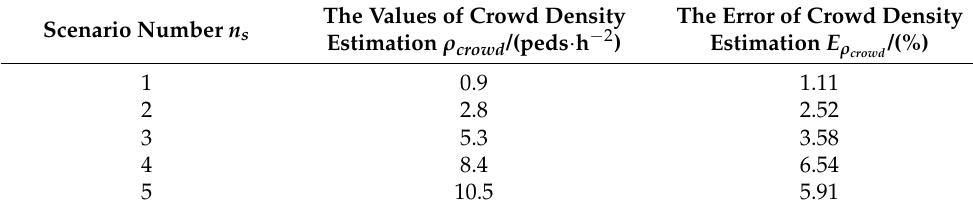
Table 3. Analysis of the accuracy of crowd density estimation. Table 2. Analysis of the accuracy of crowd density estimation.